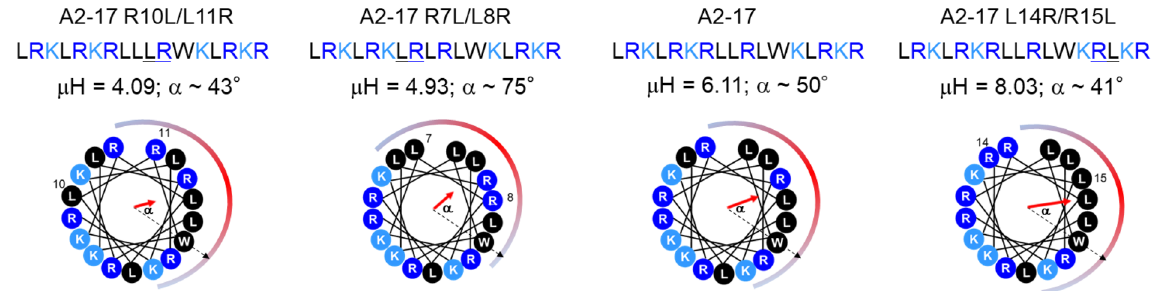
Figure 1. Structural isomers of amphipathic α-helical A2-17. The helical wheel diagrams for amino acid sequences of A2-17 R10L/L11R, A2-17 R7L/L8R, A2-17, and A2-17 L14R/R15L arranged as an ideal α-helix (100° rotation per residue) seen down the long axis from the amino-terminal end. The hydrophobic moment (μH), as a measure of amphipathicity of α-helix, for each peptide was calculated using the MPEx software (https:// blanco. biomol. uci. edu/ mpex/). The bold arrows represent hydrophobic moments as vectors. The hydrophobic domain of the helical wheel is shown by a semi-circle, at which a dotted arrow represents